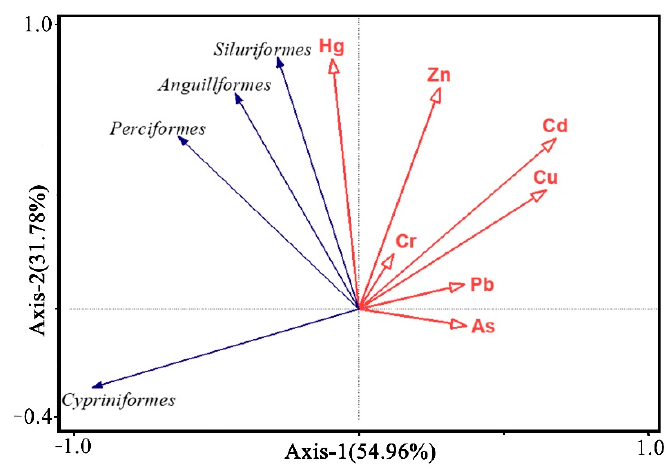
Figure 6. Redundancy analysis diagram between heavy metals and fish species.